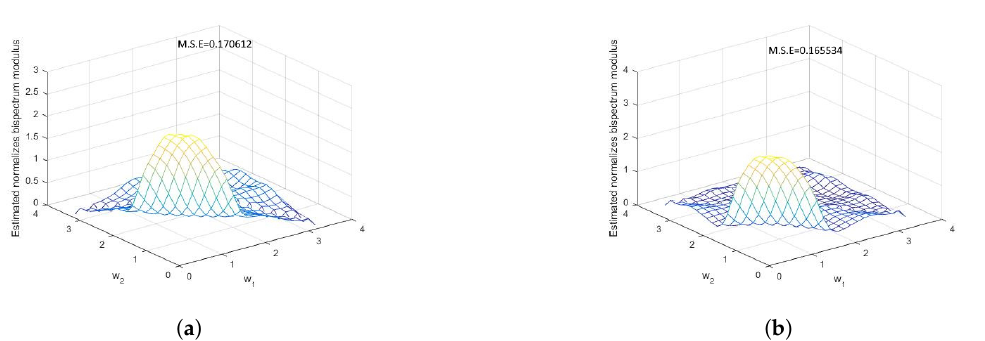
Figure 14. The estimated normalized bispectrum modulus using Tukey–Hamming window. ( a ) Gen- erated observations. ( b ) Forecasted